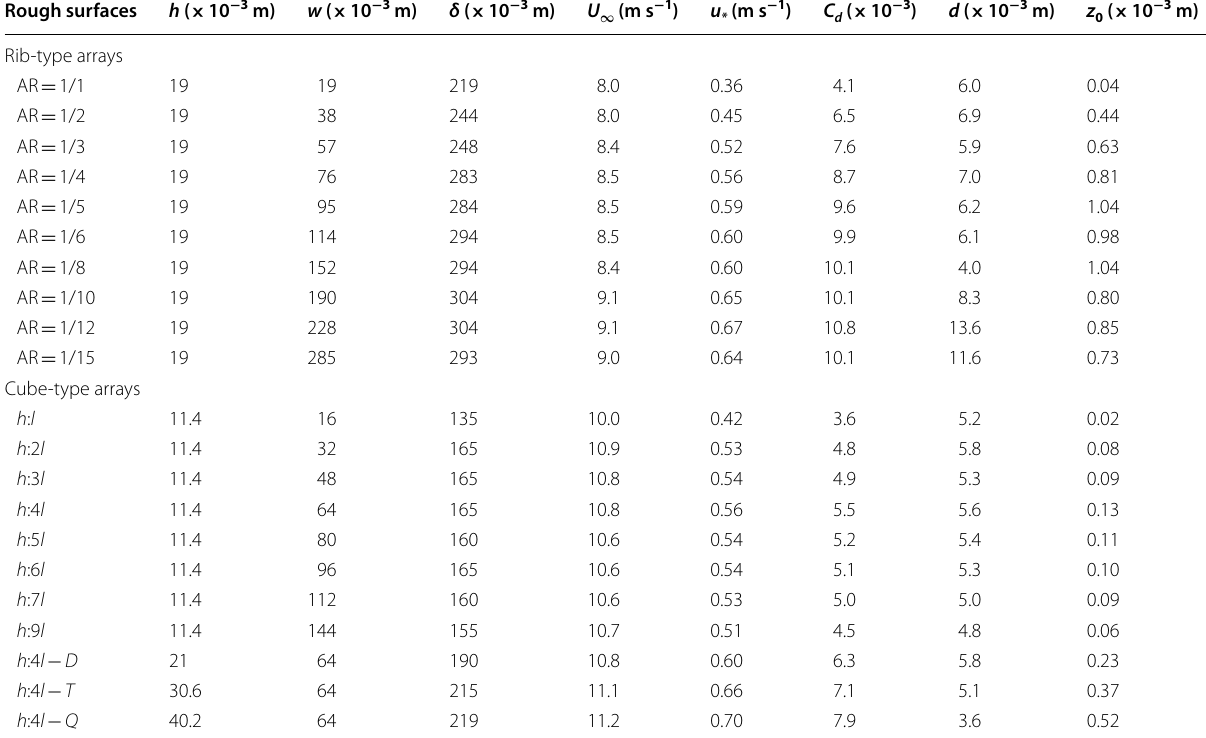
Table 1 Parameters in the turbulent boundary layers over different rough surfaces Rough surfaces h ( 10 − 3 ×